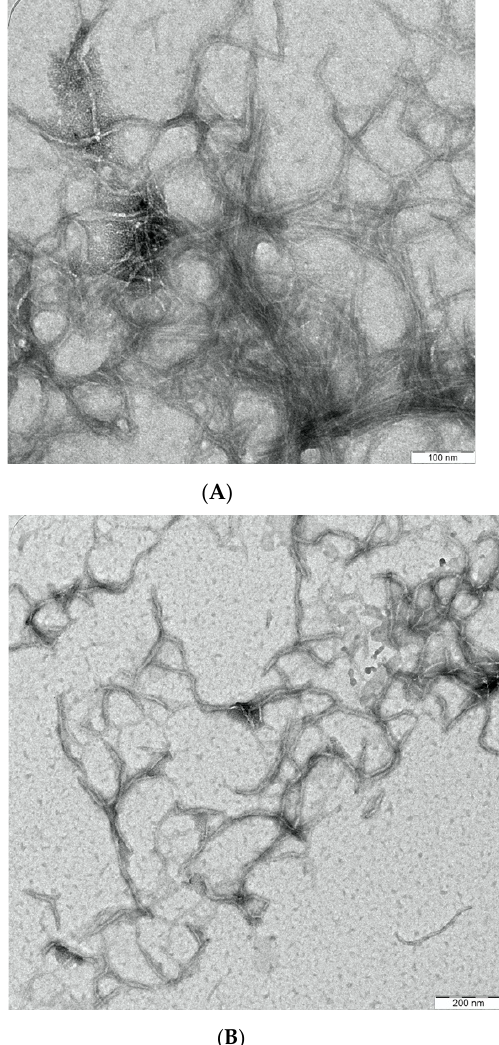
Figure 4. TEM image of CNC extracted from oil palm trunk (OPT) after acid hydrolysis treatment with magnification of ( A ) 40,000× and ( B ) 20,000×.